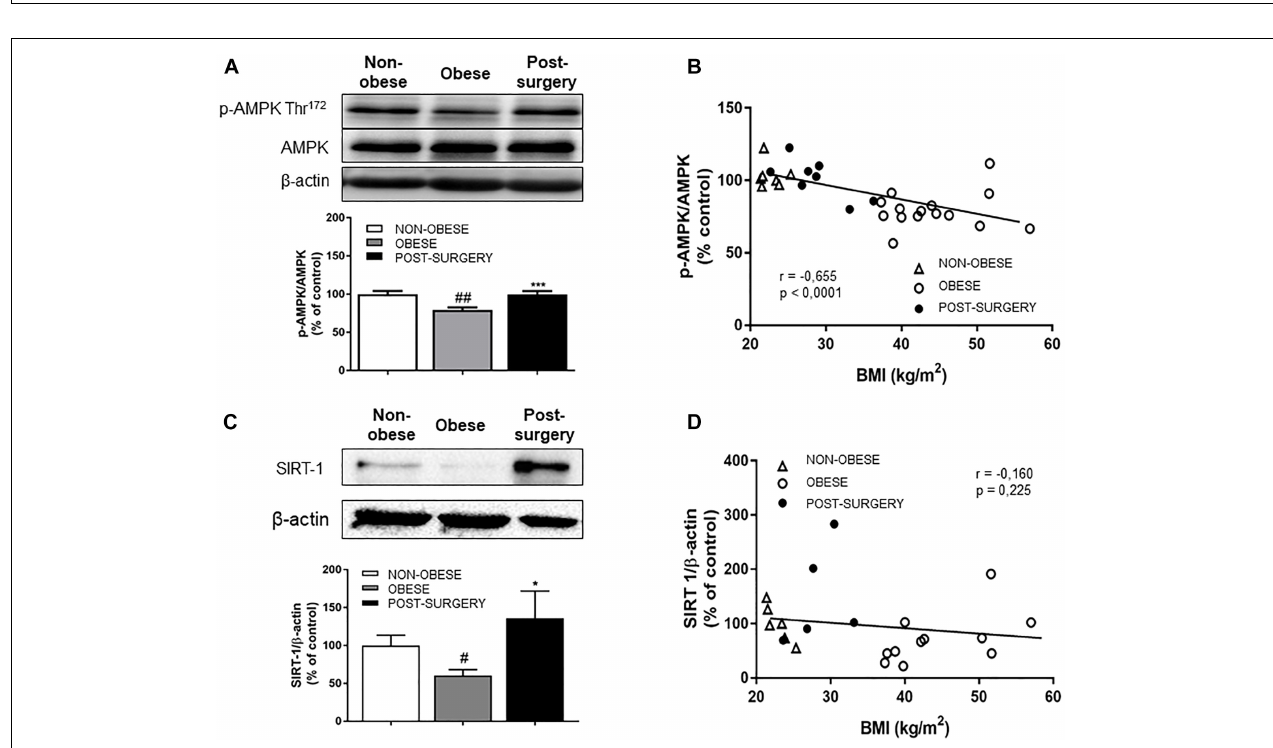
FIGURE 4 | (A) Representative immunoblots of p-AMPK/AMPK and β -actin expression in PBMCs from non-obese, obese and post-surgery patients. Diagram bars show the result of densitometric analysis of p-AMPK/AMPK immunoblots expressed as a percentage of p-AMPK/AMPK in the non-obese group. (B) Correlation between p-AMPK/AMPK and BMI. (C) Representative immunoblots of SIRT1 and β -actin expression in PBMCs from non-obese, obese and post-surgery patients. Diagram bars show the result of densitometric analysis of SIRT1/ β -actin immunoblots expressed as a percentage of SIRT1/ β -actin in the non-obese group. (D) Correlation between SIRT1/ β -actin and BMI. Data are expressed as mean ± SEM of ≥ 7 determinations per group. # p < 0.05 and ## p < 0.01 compared with the non-obese group. ∗ p < 0.05 and ∗∗∗ p < 0.001 compared with the obese group.